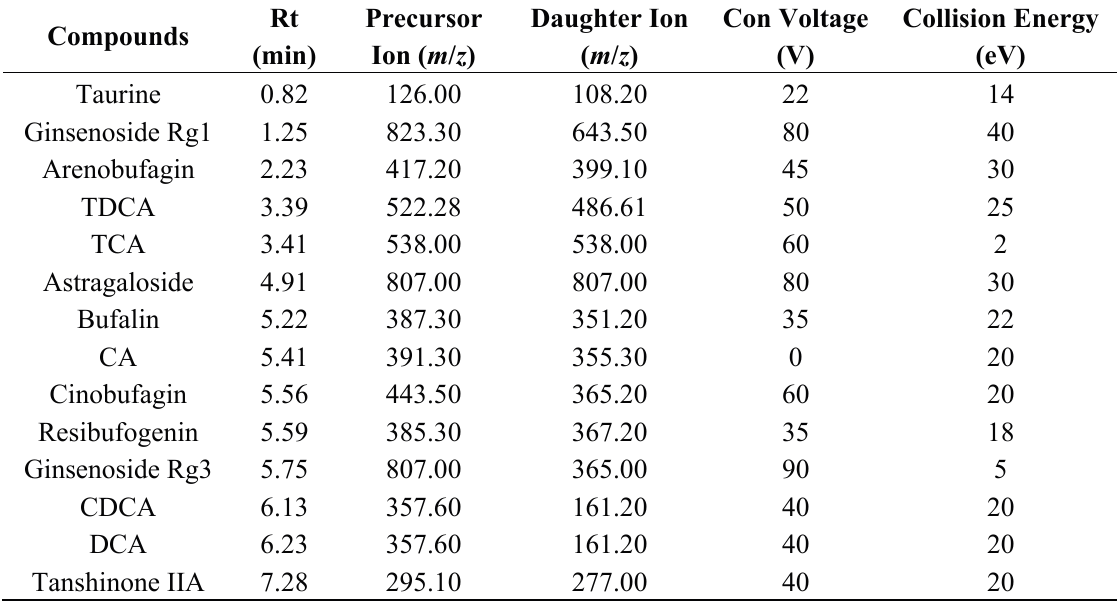
Table 6. The transitions and optimized MS parameters of 13 target markers and internal standard in the UPLC-QqQ-MS/MS